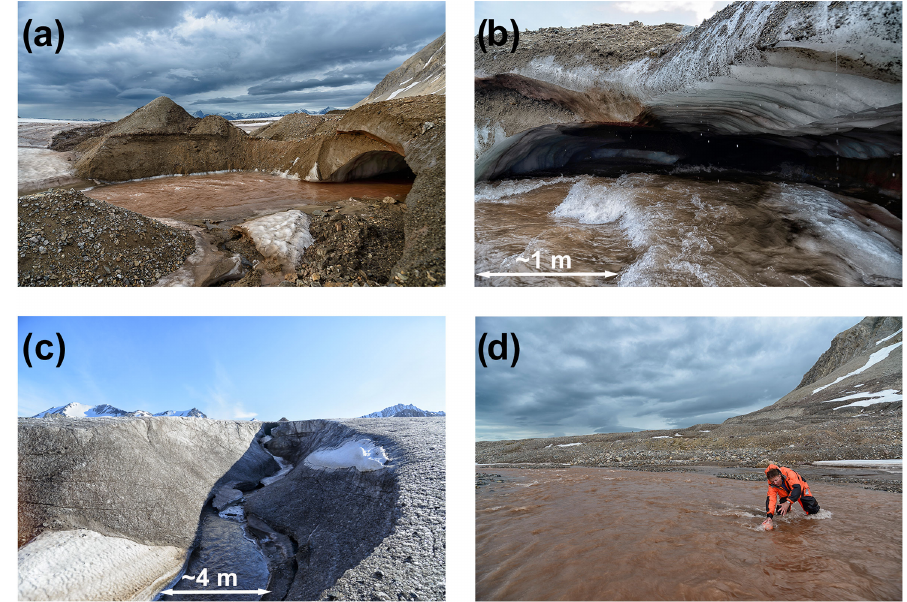
Figure 3. Pictures from the field deployments in July 2019 with approximate scale. (a) Deployment point at the englacial channel. (b) En- trance to the englacial channel. (c) Canyon following the outlet of the englacial channel. (d) Drifter recovery at the proglacial river. Im- ages: Andreas Alexander.